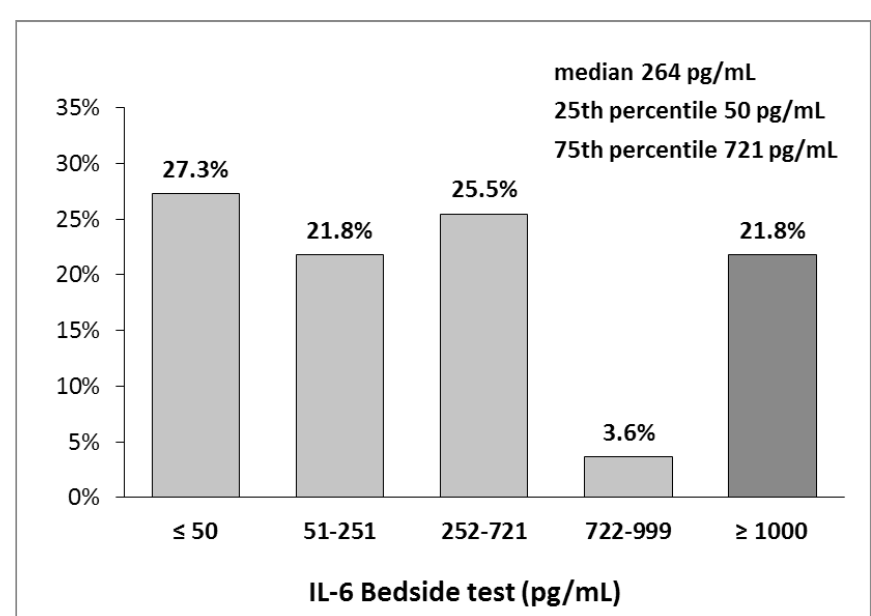
Fig. 3. Distribution of IL-6 point-of-care test values in women with PPROM.